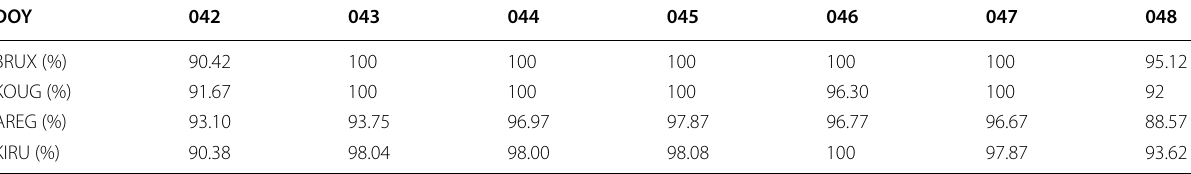
Table 1 Ambiguity fixing rates for every day of the year (DOY)